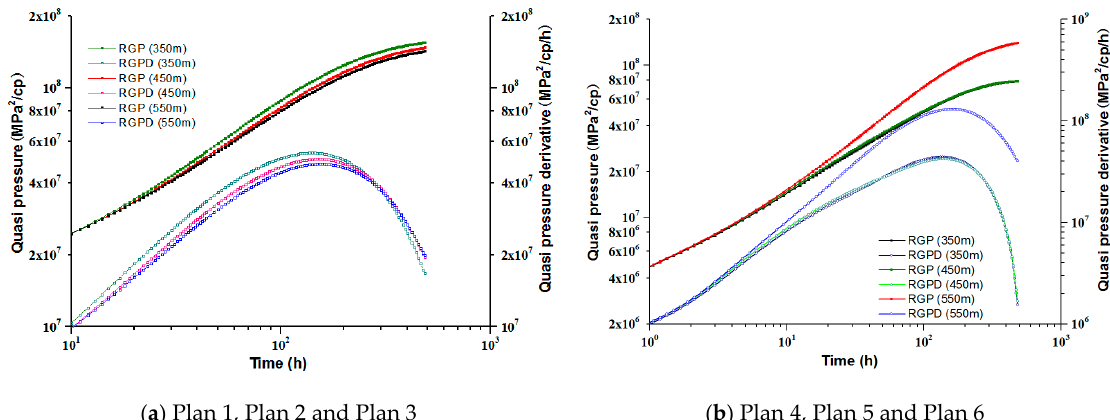
Figure 11. Double logarithmic curves of L2 build-up pressure under different well spacing.